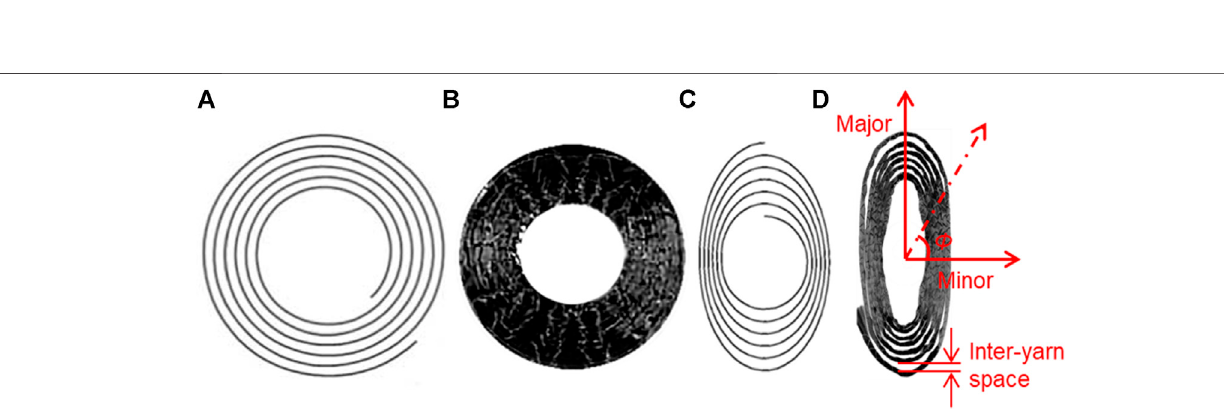
Frontiers in Materials |